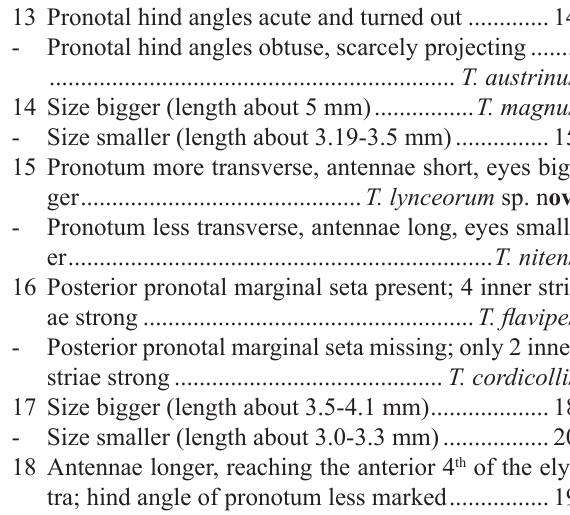
12. Elytra ovoid, broad at the base, humeri marked ... 13 Elytra pyriform, narrow at the base, humeri obsolete ..